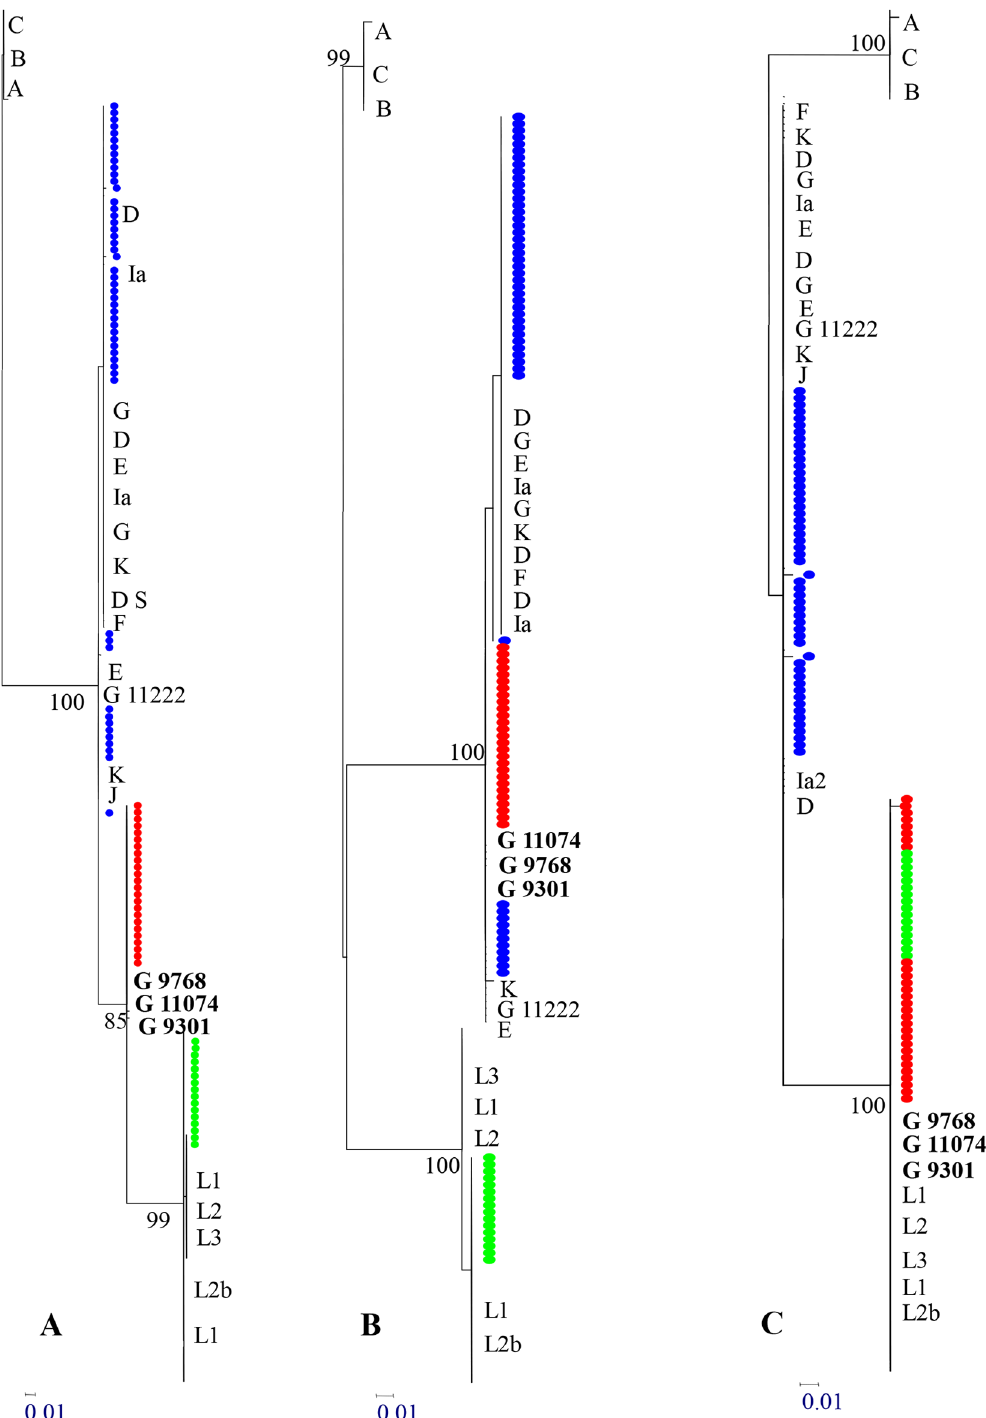
Fig 1. Maximum likelihood phylogenetic reconstruction (PhyML) identifying recombinant variants based on fragment of pmp H gene. A) Phylogenetic tree based on complete sequenced fragment of pmpH gene (407 bp). B) Phylogenetic tree based on 236 bp (corresponding to 393 – 555 and 726 – 800 nucleotides in pmpH gene) showing identity to urogenital non-invasive genotypes. C) Phylogenetic tree based on 171 bp (corresponding to 555 – 726 nucleotides in pmp H gene) showing identity to L genotype. The reference strains used in this phylogenetic reconstruction are denominated with the letter which define the genotype. A detailed description of the specific strains used in this tree is shown in Table C in S1 File. In bold we only describe the G- genotypes (G9768, G11074 and G9301) with the highest homology to strains found in Madrid. The colored circles (blue, green and red) correspond to